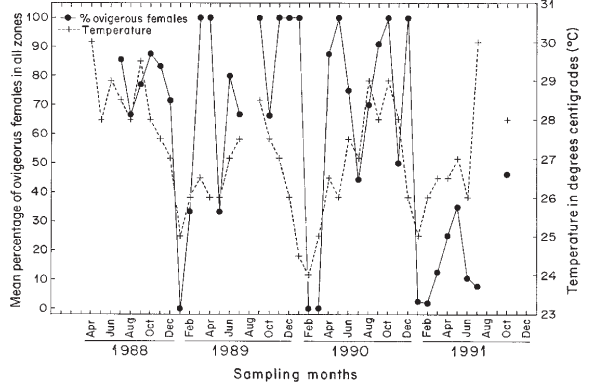
F IG . 4. – Percentage of ovigerous females of Microphrys bicornutus and surface temperature (°C) variations measured in Buchuaco (Venezuela). T ABLE 5. – Relative growth in Microphrys bicornutus . Regression lines of carapace length (CL) against chela width (CW) of pre- pubertal and post-pubertal males, and CL against abdomen width (AW) of pre-pubertal and post-pubertal females. Measurements in mm were log-transformed.